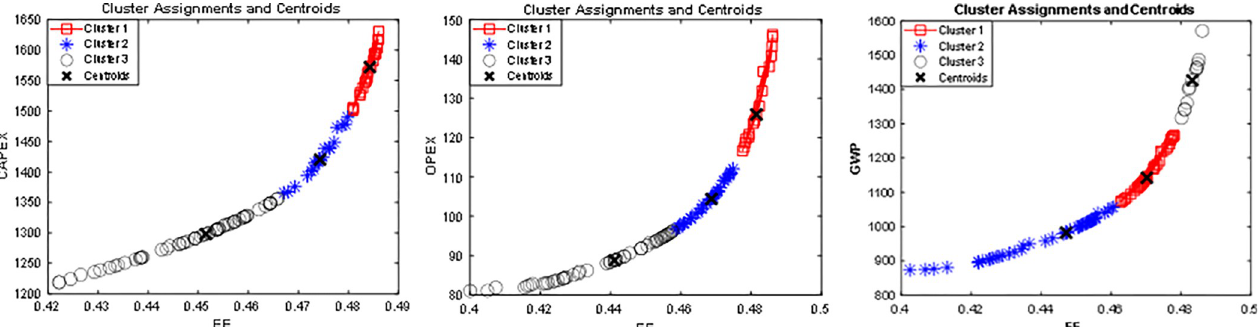
Fig 11. K-means clustering of the Pareto optimal solutions, a) CAPEX, b) OPEX, and c) GWP.